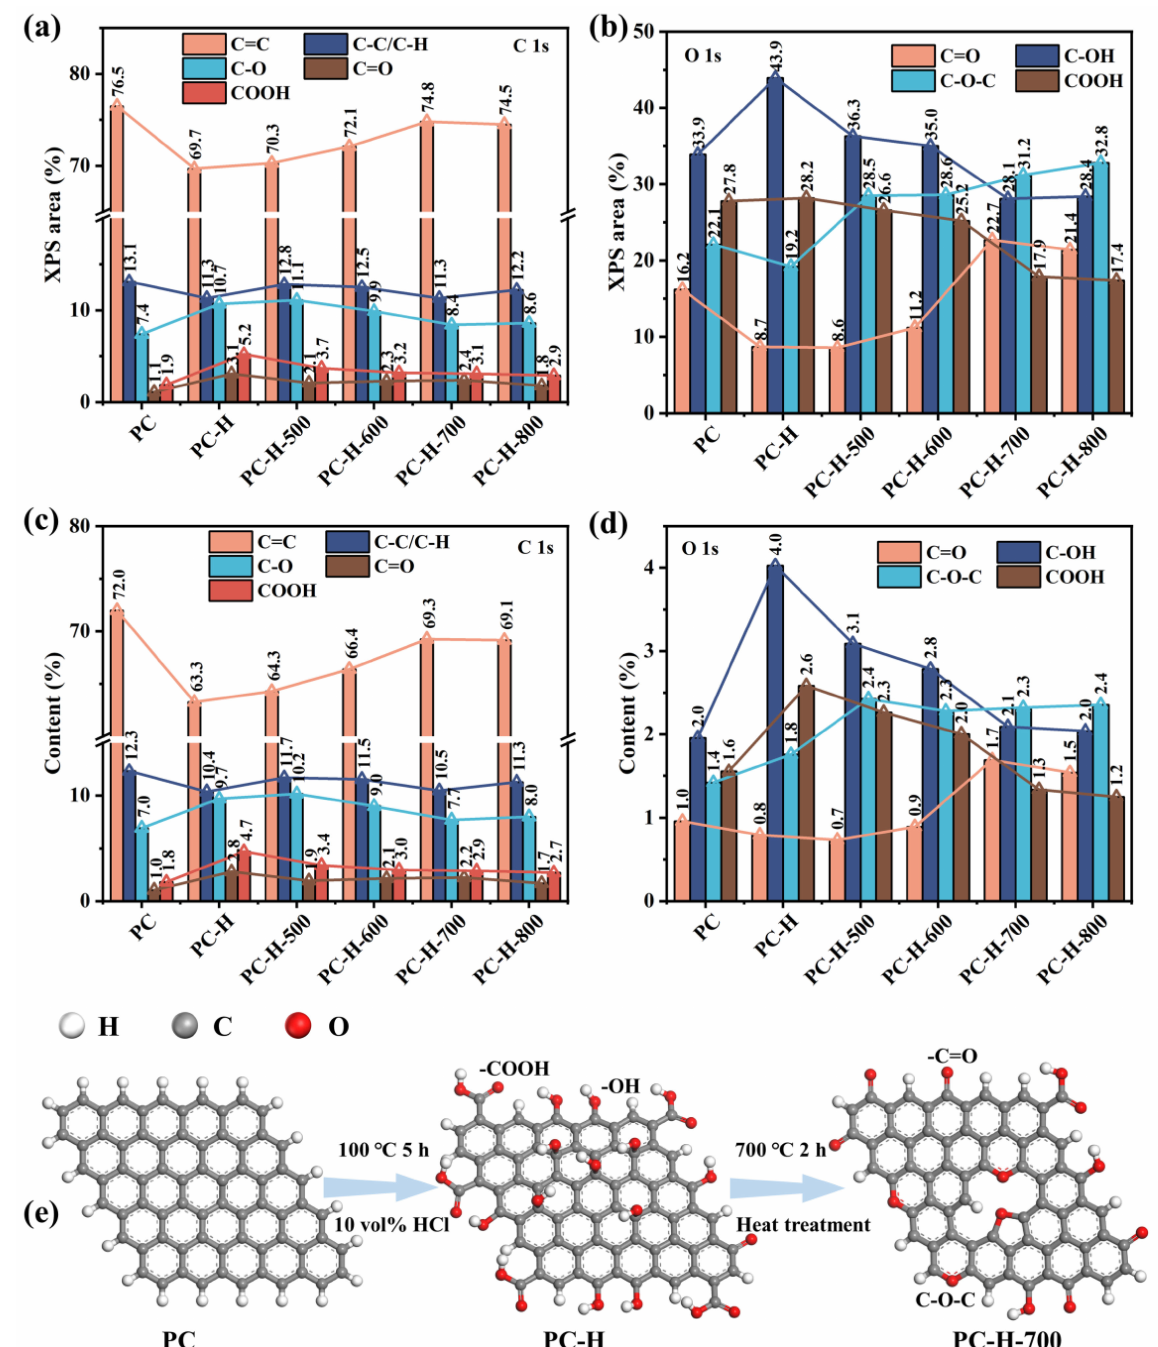
Figure 4. Histograms of XPS area ratios deconvoluted from C 1s ( a ), and O 1s ( b ). Histograms of the content ratios deconvoluted from C 1s ( c ), and O 1s ( d ). ( e ) Schematic representation of oxygen functional groups on modified